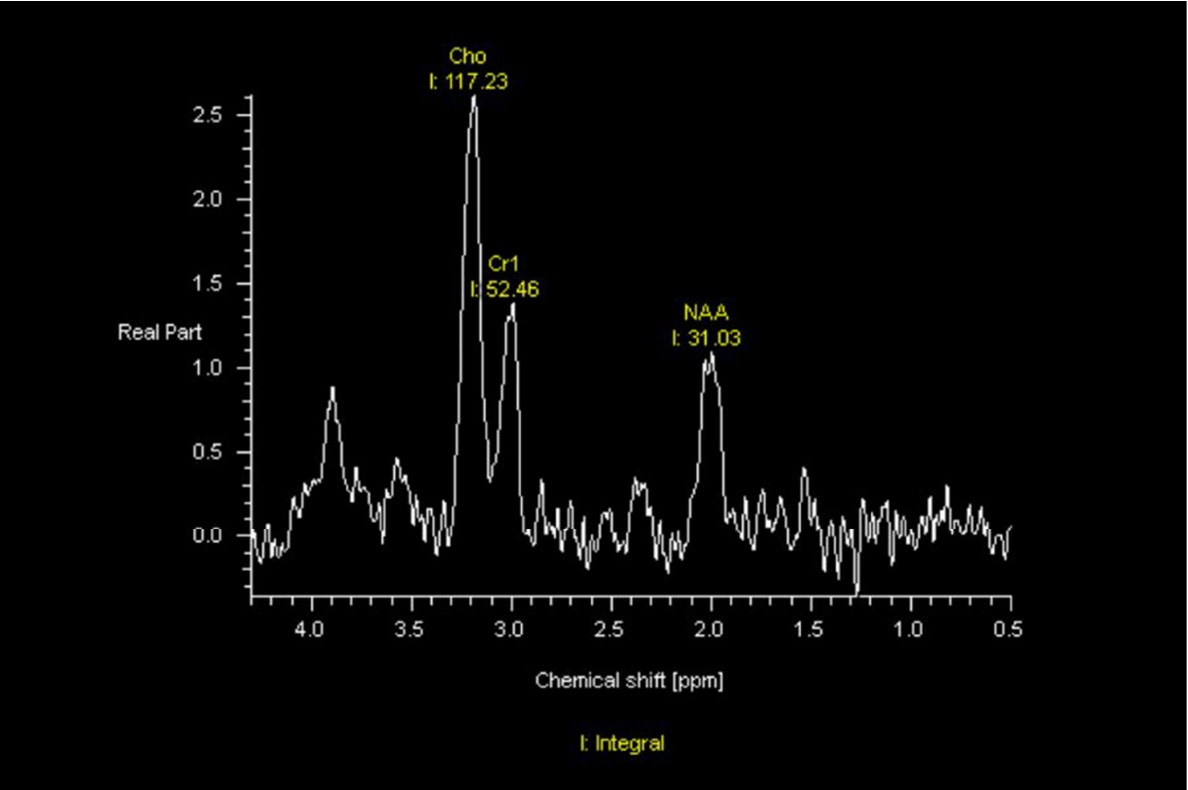
Figure 1. MR Spectroscopy shows reversal of Hunter’s angle with elevated choline (Cho), decreased creatine (Cr), and decreased N-acetyl-aspartase (NAA) in a patient with GBM status post radiation therapy, temozolomide, and tumor treating fields.